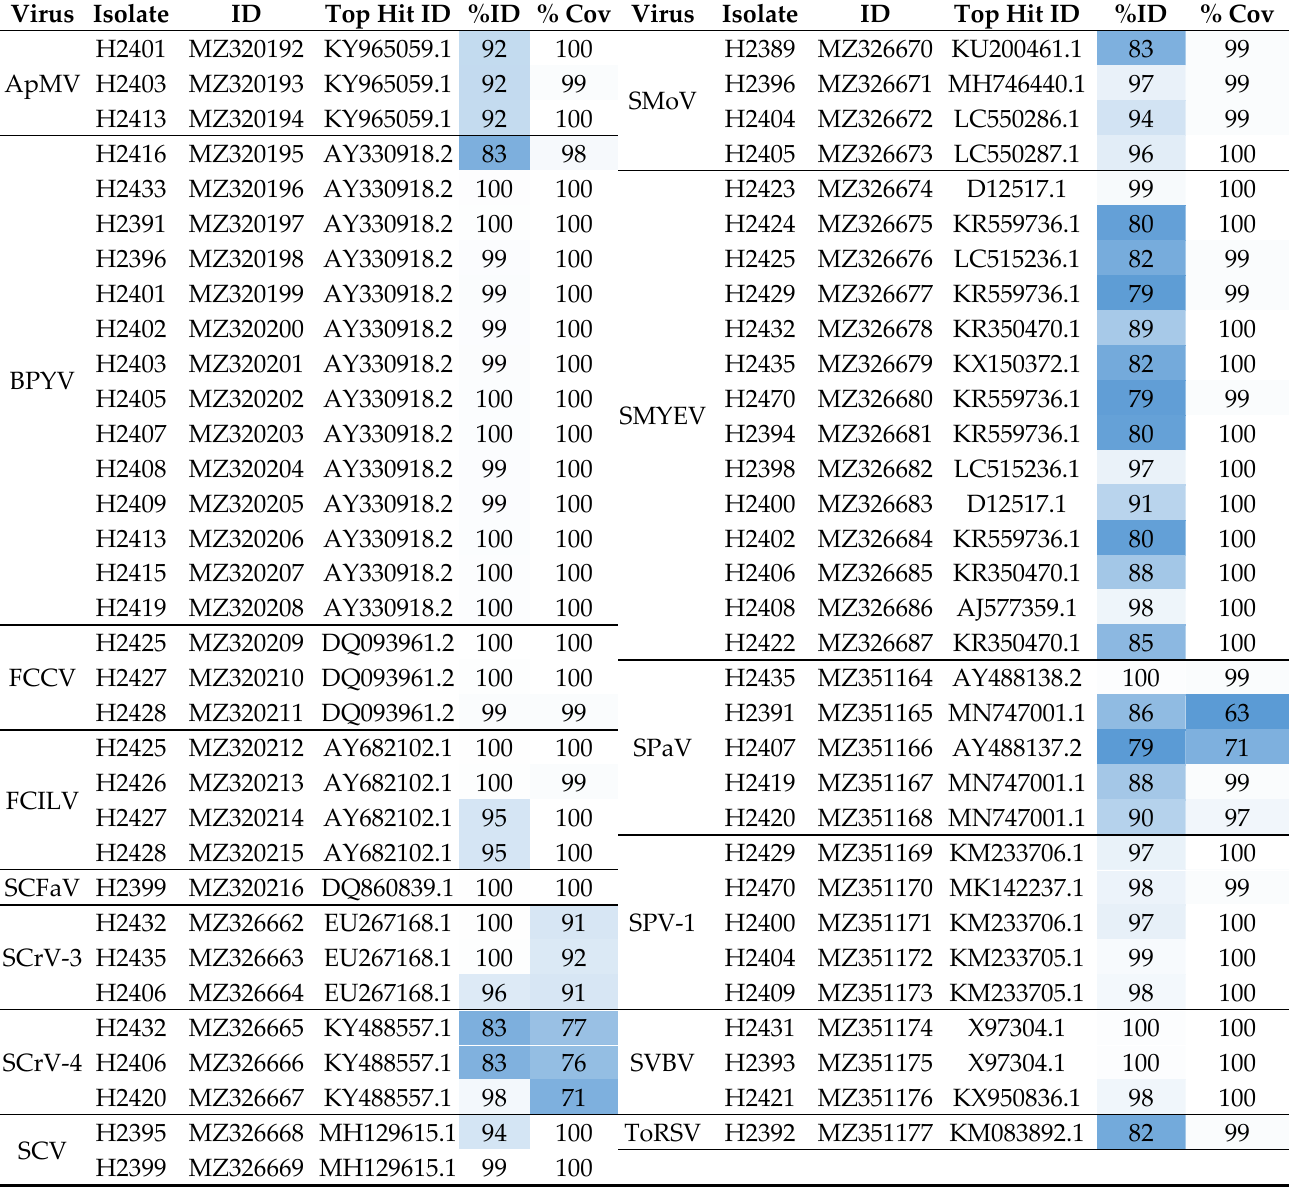
Table 2. New isolate sequences of strawberry-infecting viruses and their closest homolog in GenBank. Virus